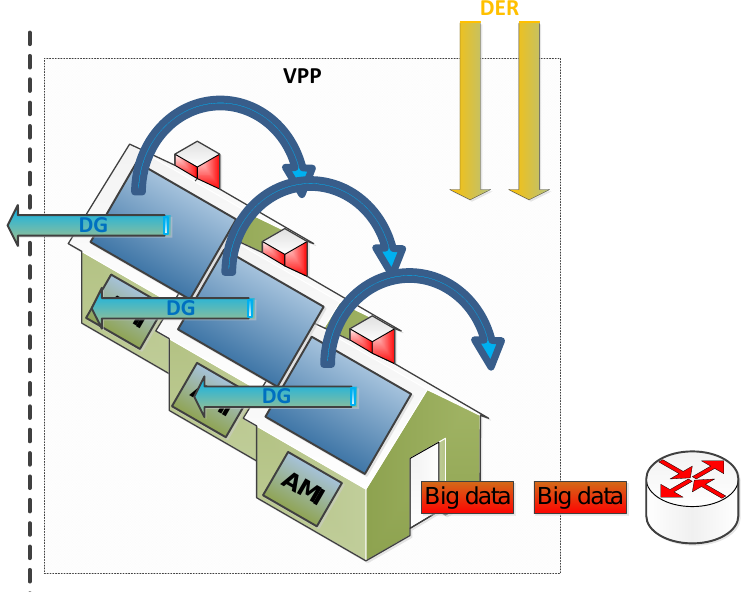
Figure 3. Close-up view of the prosumer scenario with a Virtual Power Plant (VPP). AMI: Advanced Metering